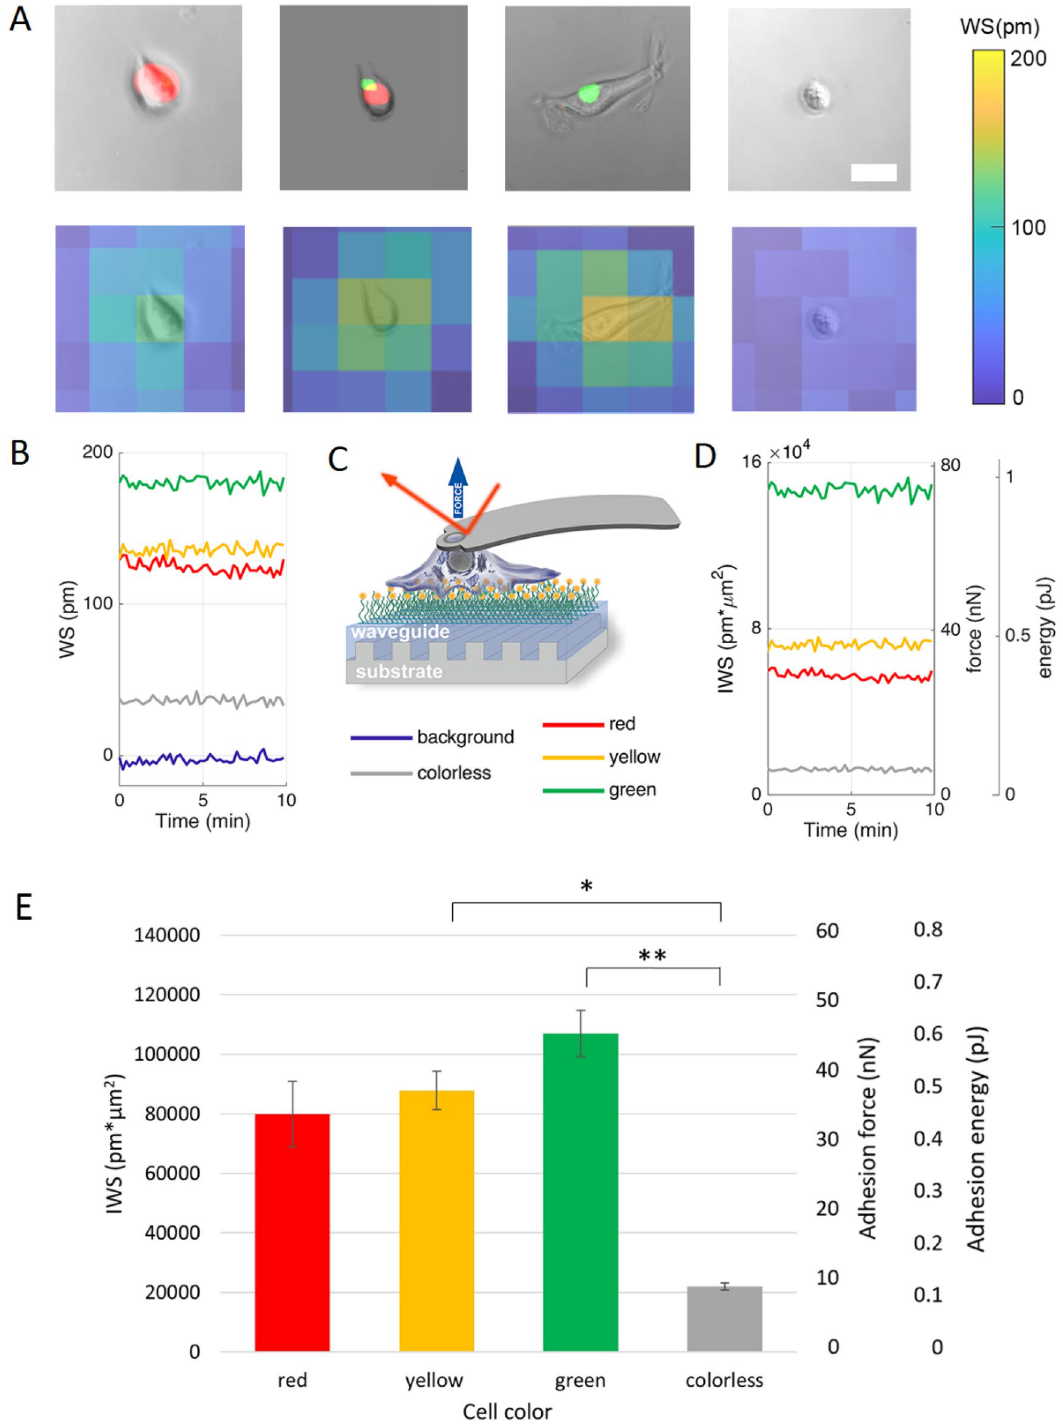
Figure 4. Comprehensive representation of the biosensor data. ( A ) Top row: Phase contrast and fluorescent composite images of typical red, yellow, green, and colorless cells (respectively). Scale bar represents 25 µm. Bottom row: Composite images of the respective top row cells overlayed from the biosensor wavelength shift map and the phase contrast image at t = 10 min. ( B ) Near-stationary time dependence of maximal biosensor pixel values (WS) for representative cells depicted in Fig. 4A. ( C ) Schematic representation of the robotic fluidic force microscopy (FluidFM BOT) measurement process. A special hollow FluidFM cantilever capable of whole cell force-spectroscopy was used to calibrate biosensor signals for adhesion force and energy conversion as described in 41 . ( D ) Time-dependence of IWS and deduced force/energy signals of single cells in different phases of the cell cycle. ( E ) Correlation between cell color and IWS, adhesion energy, and adhesion strength. A significant difference was found between colorless cells with respect to green and yellow cells. Graphs show the average of n = 7 red cells, n = 11 green cells, n = 8 colorless cells, and n = 11 yellow cells ±